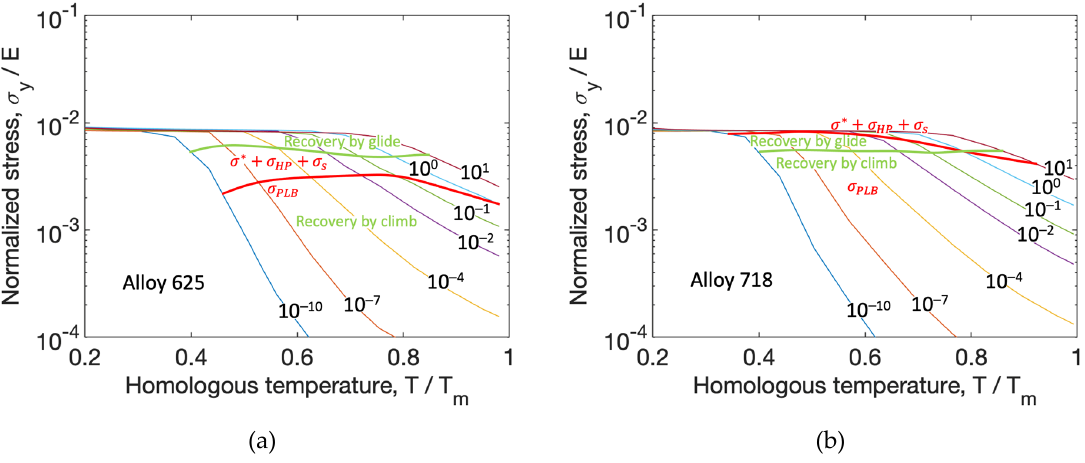
Figure 7. Deformation mechanism maps for alloy 625 ( a ) and alloy 718 ( b ). The x-axis shows the